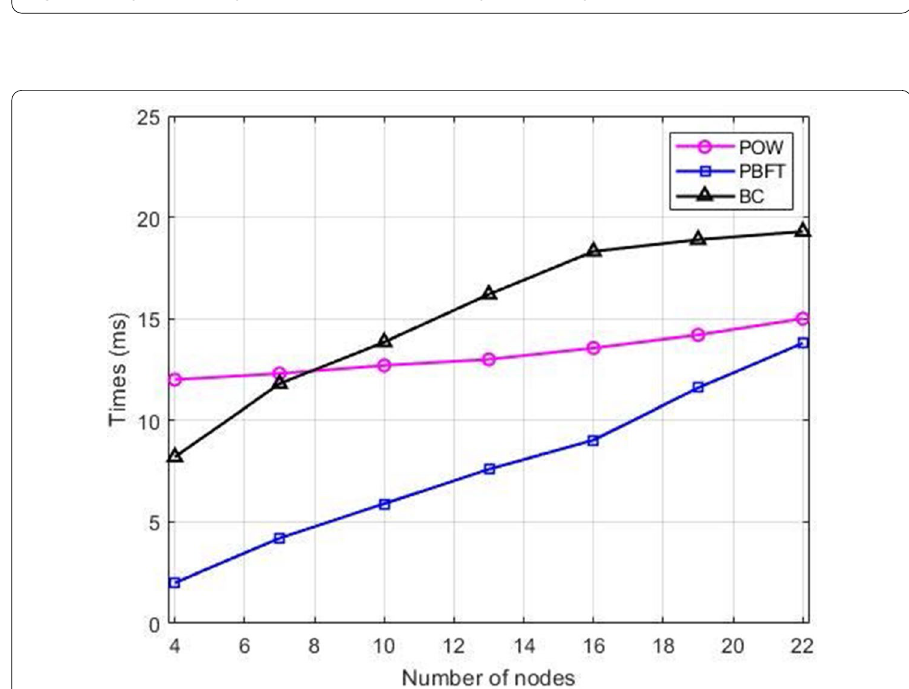
Fig. 9 Average time to agreement; Illustration of the Average time to